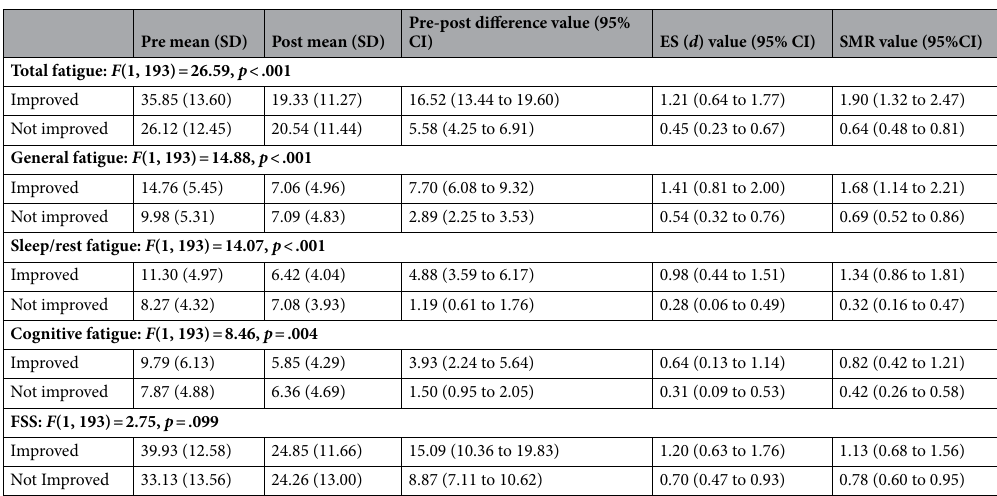
Table 4. Mean differences in PedsQL-MFS scores according to CESD change category.